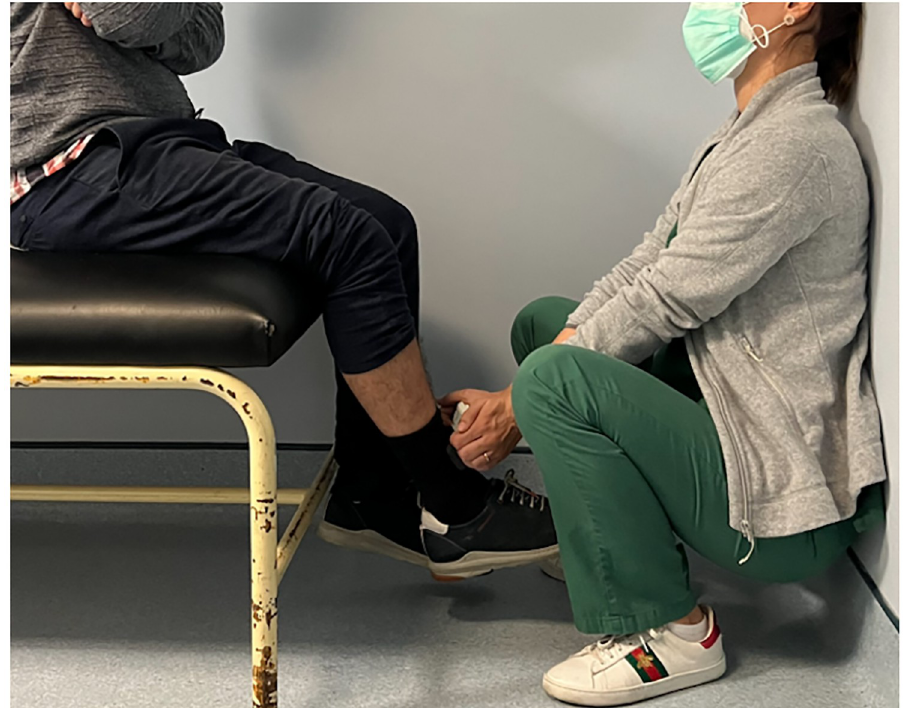
Fig 2. Standardized evaluation method of the patients. Observer was squatting with back against the wall and stretch arms in order to increase stability.